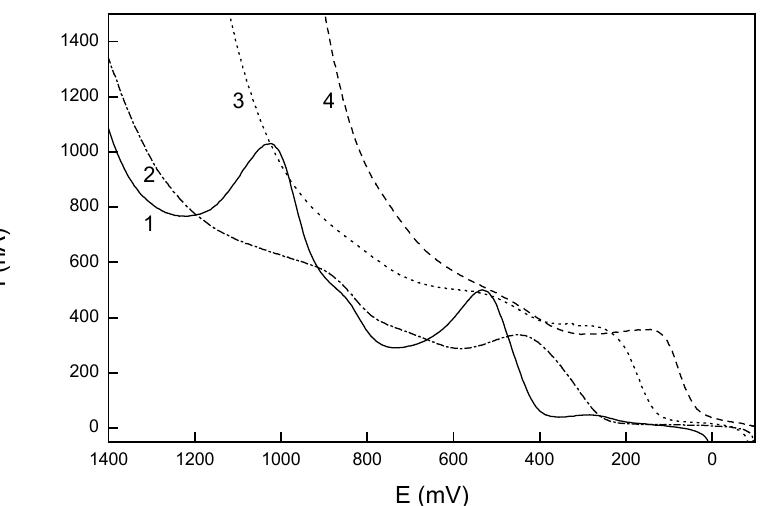
Figure 1. Selected LS voltammograms of 1-AP (c=1.10 -4 mol.L -1 ) at GCPE in mixture